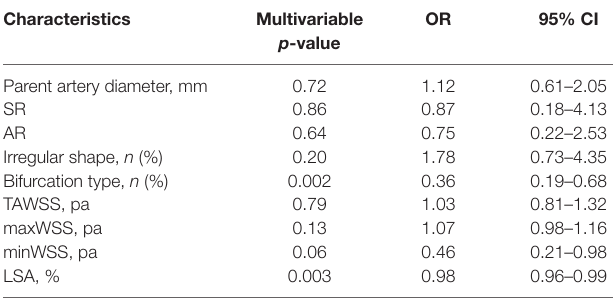
TaBle 3 | Multivariable logistic regression analysis of risk factors for rupture of Vsias. characteristics Multivariable